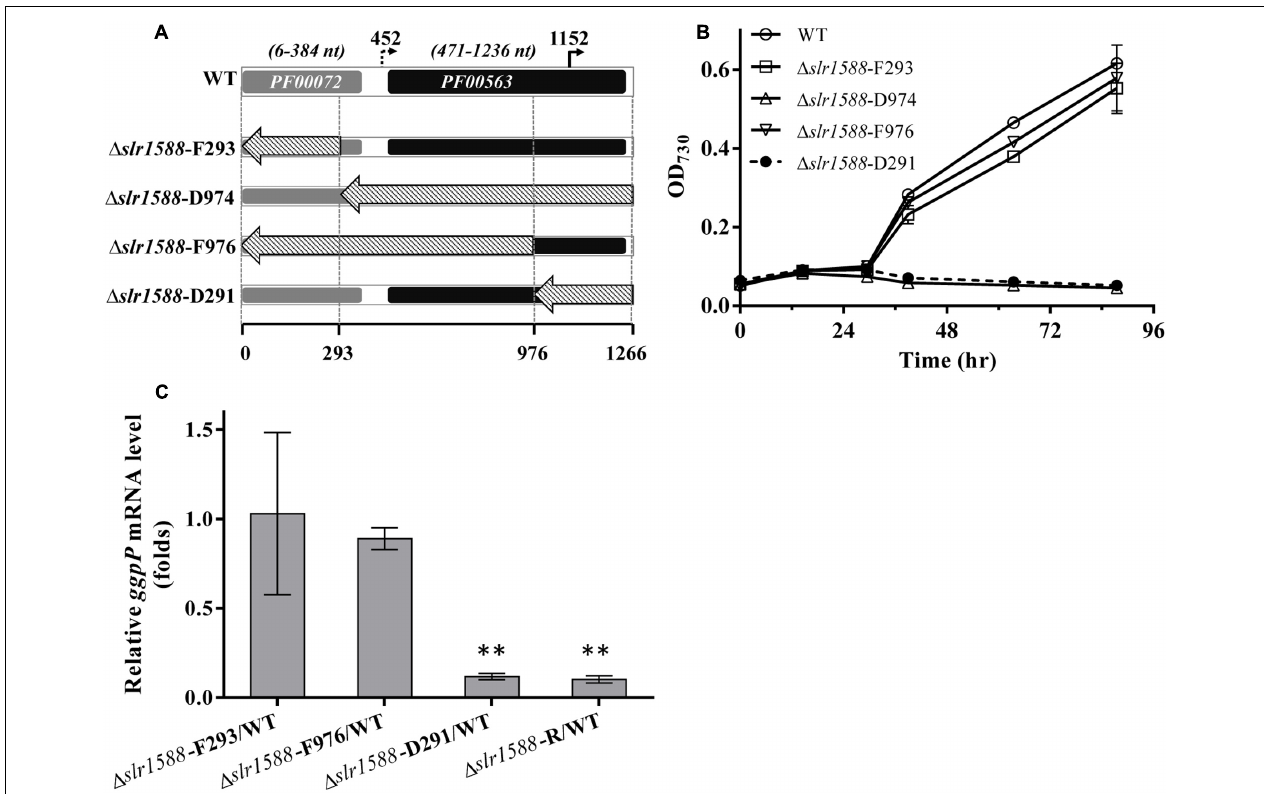
FIGURE 3 | Salt tolerance and transcript levels of the ggpP gene in cells of mutants with partly deleted slr1588 . (A) DNA fragments from positions 1 to 293, 294 to 1266, 1 to 976, and 977 to 1266 of slr1588 coding sequence were replaced by the Km r fragment resulting in the (cid:49) slr1588 -F293, D974, F976, and D291 mutants, respectively. (B) Growth curves of the four partly deleted slr1588 mutants and the WT strain in BG11 supplemented with 4% NaCl. (C) ggpP transcript levels relative to WT cells in three slr1588 mutants grown in BG11 supplemented with 4% NaCl for 24 h. The stars ( ∗∗ ) indicate significant differences ( p <